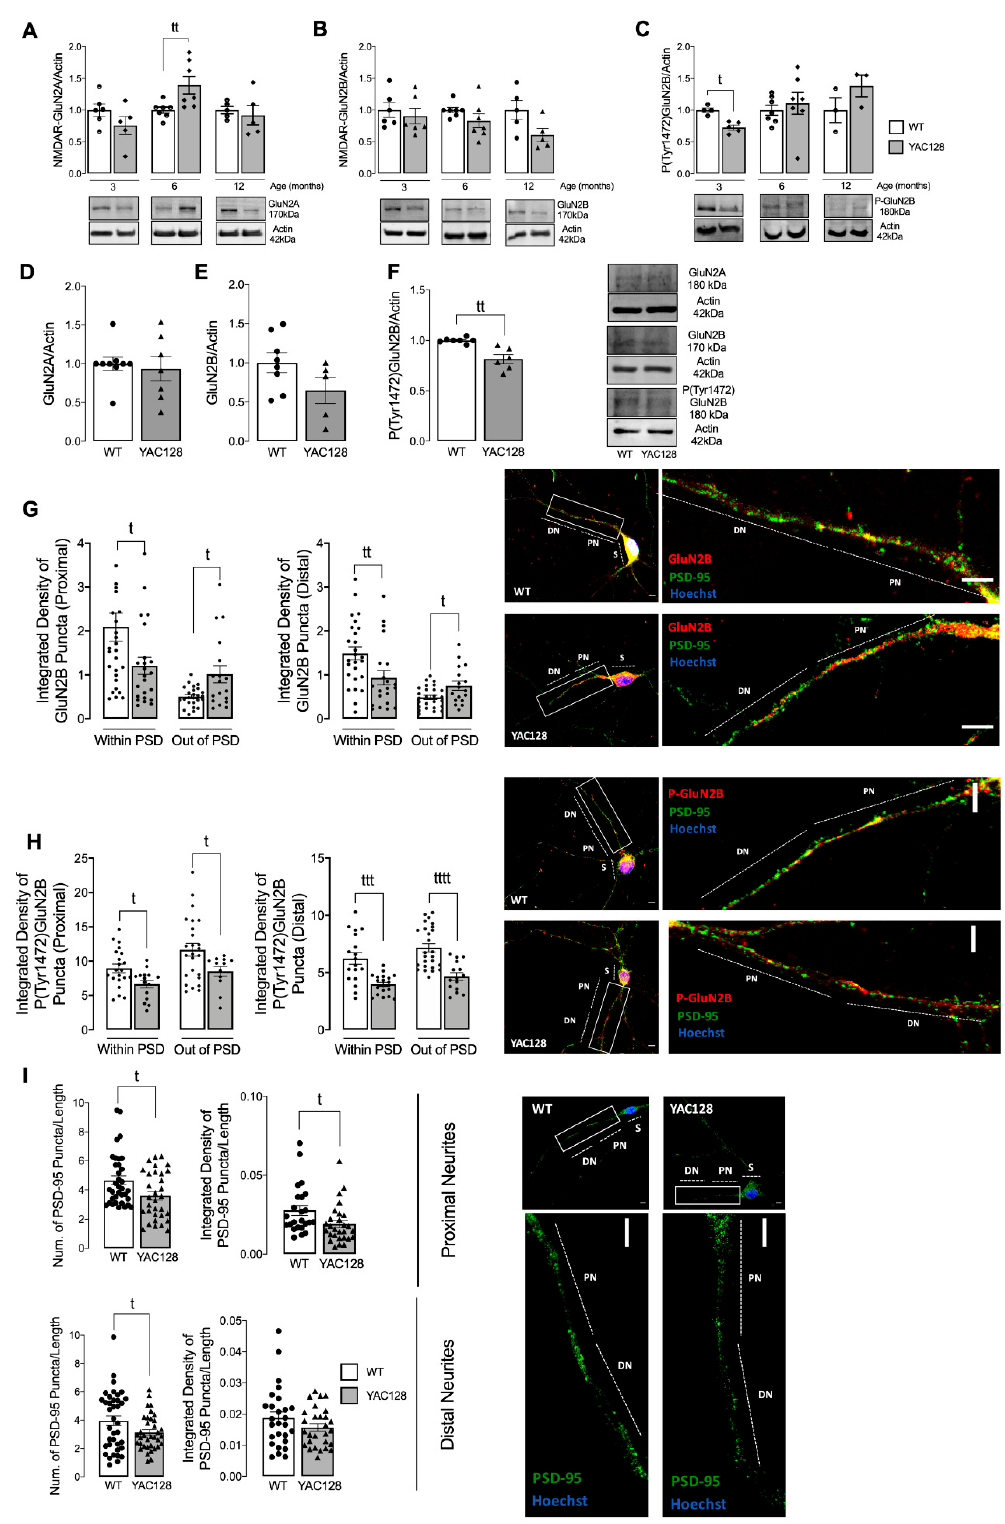
Figure 1. Altered GluN2A- and GluN2B-composed NMDARs levels in HD models. GluN2A/Actin ( A , D ) , GluN2B/Actin ( B , E ) and P(Tyr1472)GluN2B/Actin ( C , F ) were analyzed by Western blotting in total extracts obtained from striatal tissue from WT and YAC128 mouse brain ( A – C ) and total extracts obtained from primary striatal mouse YAC128 and WT neurons ( D – F ) . Data are expressed